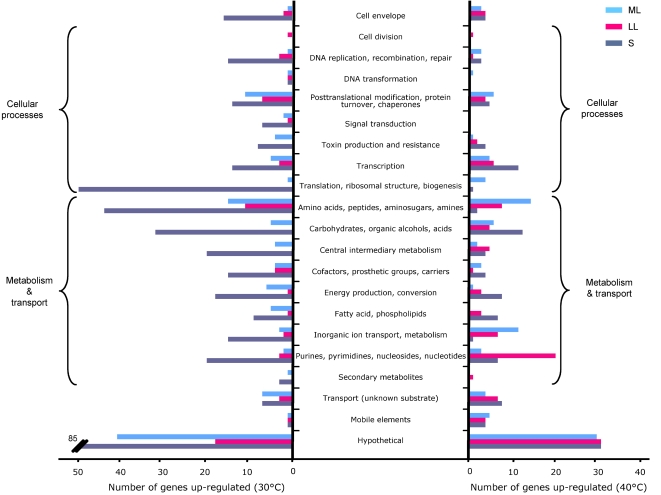
Differential regulation of gene expression in GBS strain NEM316 at 30°C and 40°C.Genes were classified into 21 main functional categories. Bars indicate the numbers of genes up-regulated at one temperature in mid-logarithmic (ML), late logarithmic (LL), and stationary (S) phase.